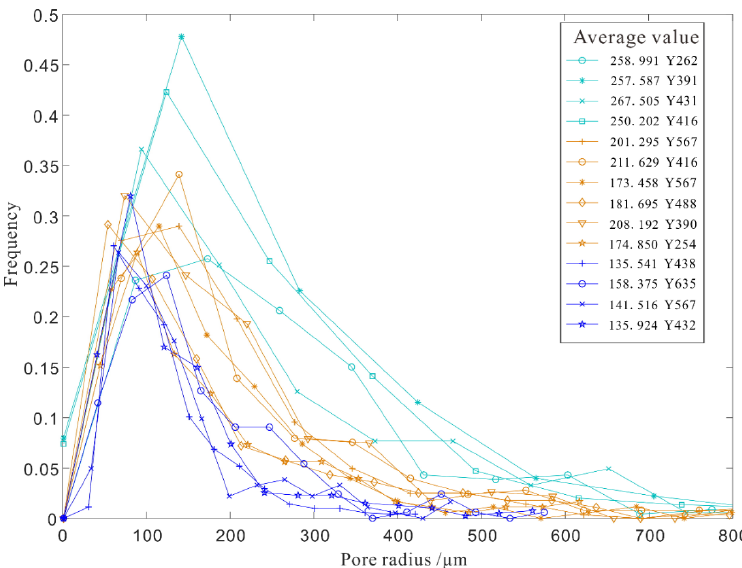
Figure 4. Distribution map of different types of pore radius.